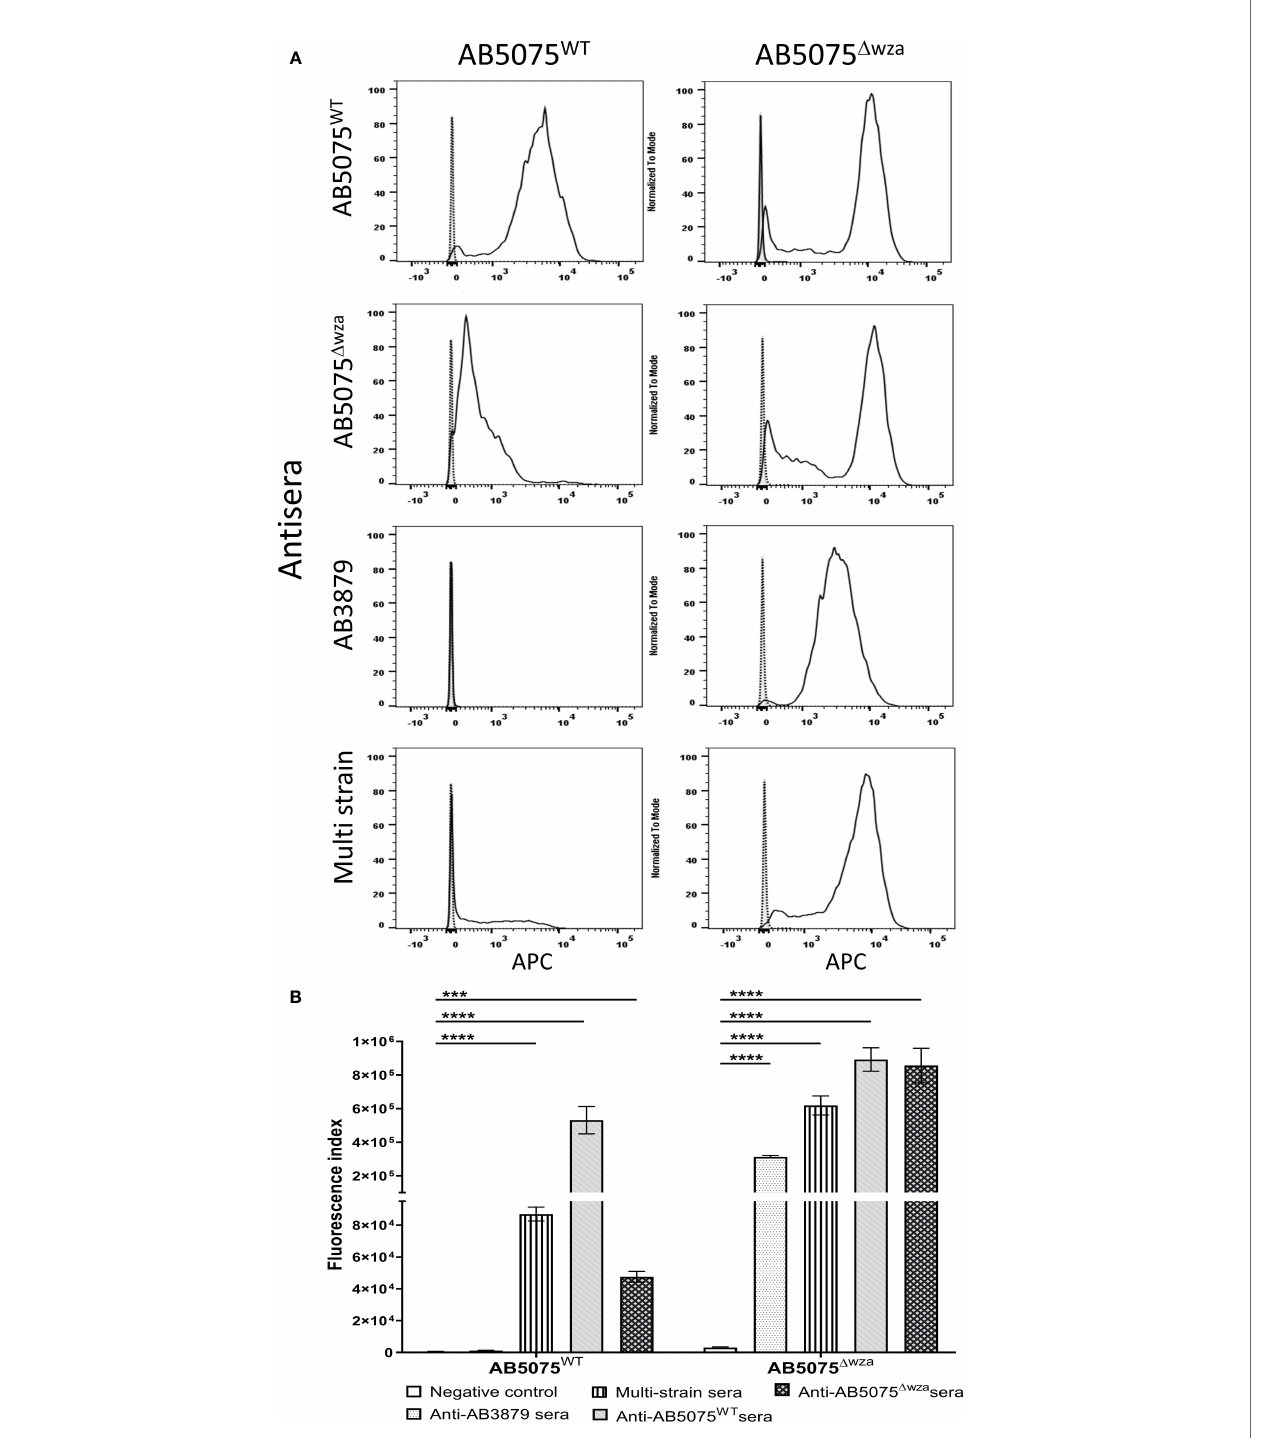
FIGURE 2 | Flow cytometry detection of IgG binding to wild type and un-encapsulated AB5075 isolates by mouse antisera. Representative histograms showing the recognition of 1x10 6 CFU of AB5075 wild-type strain (left panel) and un-encapsulated AB5075 D wza strain (right panel) to either (A) AB5075 WT , AB5075 D wza , AB3879 or multi strain antisera. (B) Bar graph presenting the proportion of AB5075 WT and AB5075 D wza bacteria bound by IgG in AB3879, multi strain, AB5075 WT or AB5075 D wza antisera. The Y axis shows the fl uorescence index calculated by multiplying the percentage of IgG positive bacteria to the median fl uorescent intensity of the positive population that was detected in each isolate. Bars represent mean values for each condition/strain and the error bars indicate standard deviations (SDs) (n = 3). T-test was used for statistical analysis ***p-value < 0.001, ****p-value =< 0.0001. Representative data from two independent experiments is